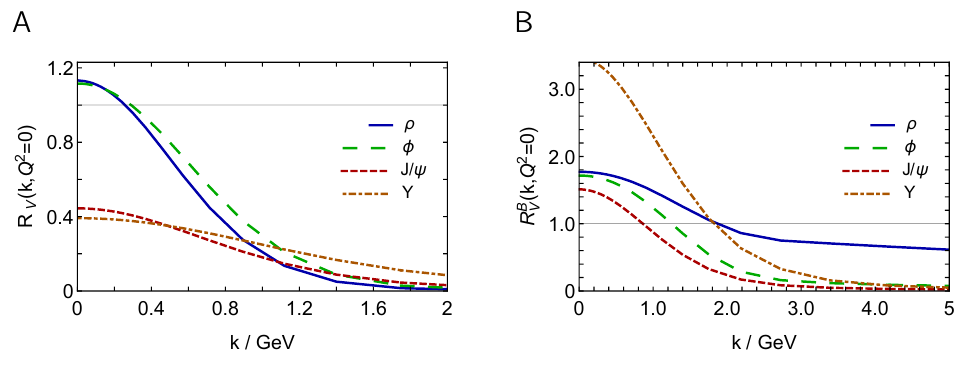
Figure 13. Left panel ( A ): First ratio in Equation (29) computed using matched solutions of the gap and Bethe–Salpeter equations for V = ρ , φ , J / ψ , Υ . Right panel ( B ): Second ratio in Equation (29), computed similarly. In cases where the VMD hypothesis were sound, all these curves would lie close to the thin horizontal line drawn at